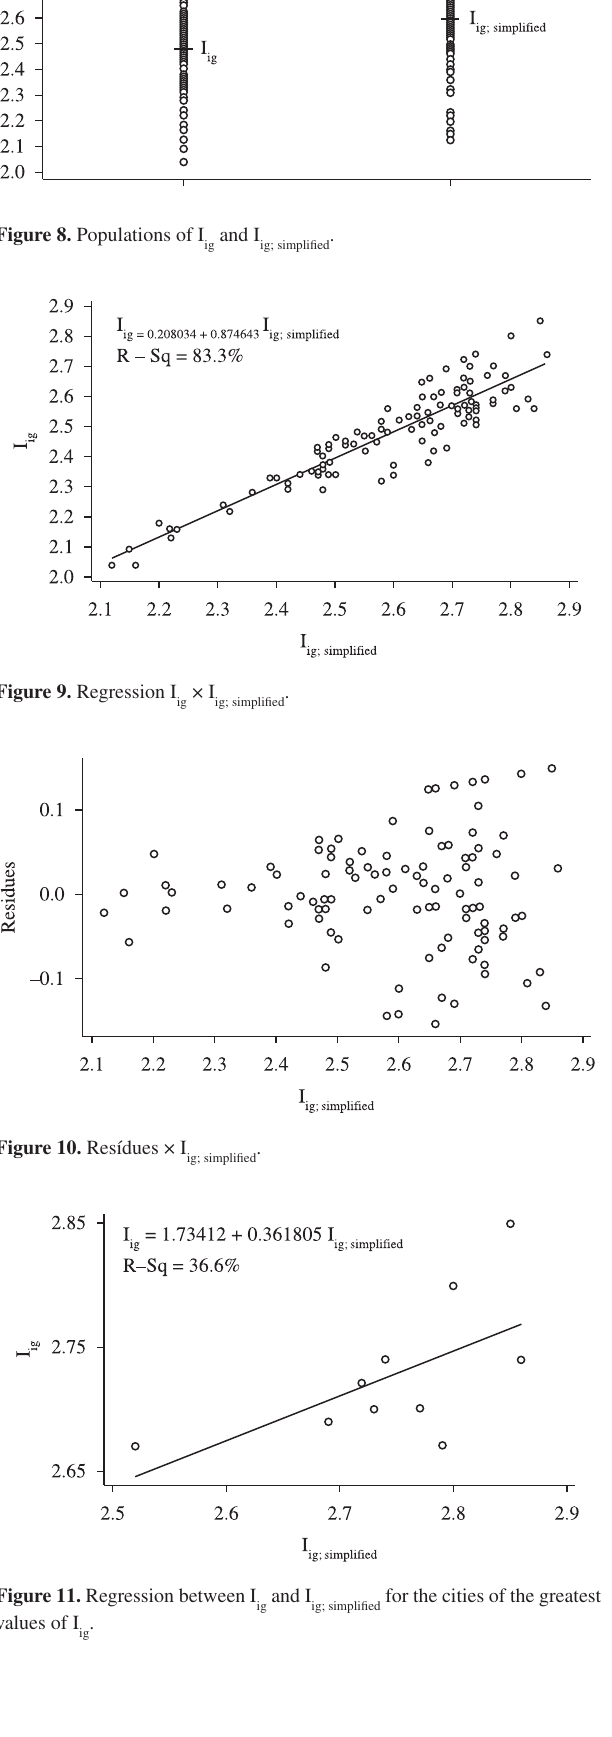
Figure 11. Regression between I values of I . ig